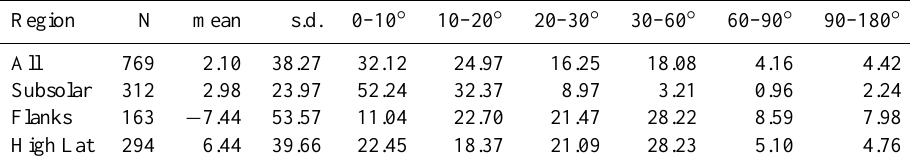
Table 7. Distribution of angular differences in the B y positive case (IMF clock angle between 45 ◦ and 135 ◦ ). Format as in Table 3. Region N mean s.d. 0–10